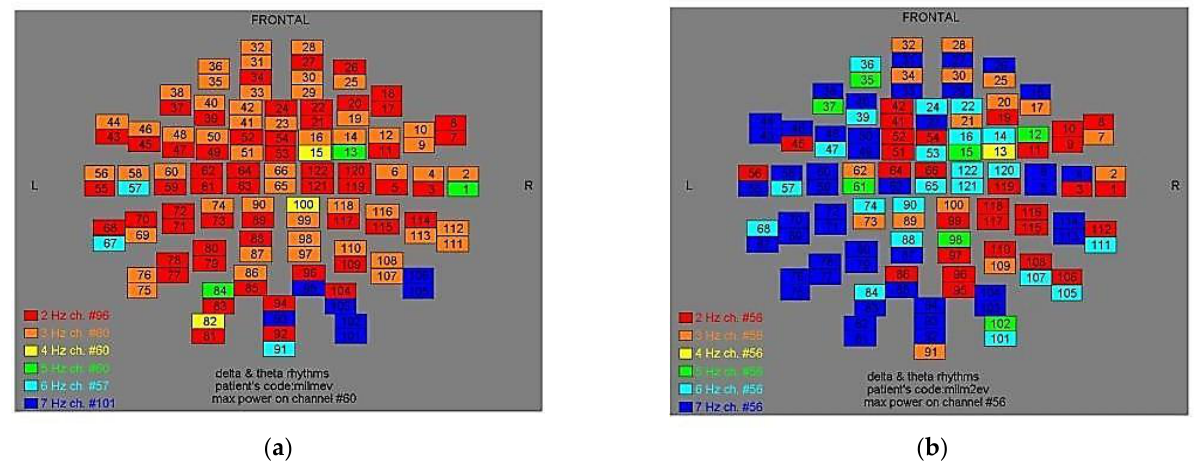
Figure 7. Dominant frequency color mapping for patient #6, before ( a ) and after ( b ) magnetic stimulation .